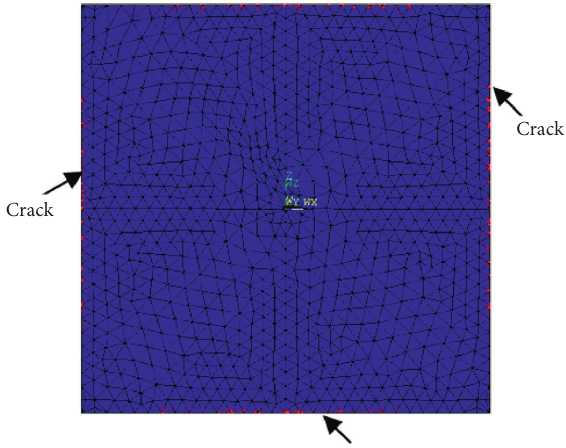
x in the methods; (b) stress σ y in the methods.